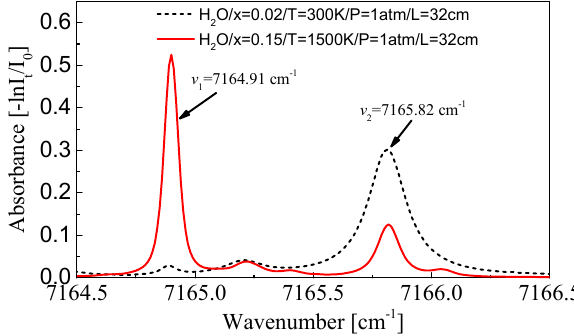
Figure 5. The simulated two H 2 O absorption spectra ( v 1 = 7164.91 cm − 1 and v 2 = 7165.82 cm − 1 ) at T = 300 K, x = 2% (black dot line) and 1500 K, x = 15% (red solid line).